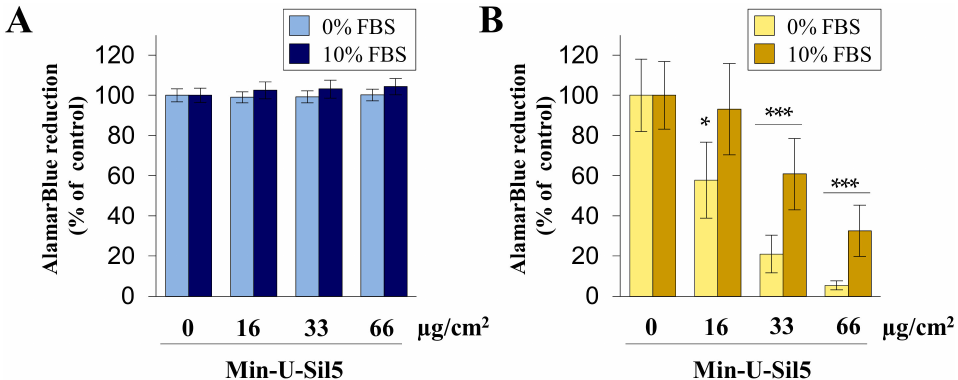
Figure 1. Metabolic activity of A549 ( A ) and dTHP-1 ( B ) cells after submerged exposure to Min-U-Sil5. A549 cells and dTHP-1 cells were treated with 0, 16, 33, or 66 µ g/cm 2 Min-U-Sil5 (0, 50, 100, or 200 µ g/mL) either with or without FBS for 24 h. The cells were analyzed for AlamarBlue reduction which is shown relative to the untreated control (100%). The means ± SD of three independent experiments performed in duplicates are displayed. Statistical analysis was performed to assess dif- ferences between the cells cultured in media with and without FBS using student’s t -test: * ( p ≤ 0.05), *** ( p ≤ 0.001).